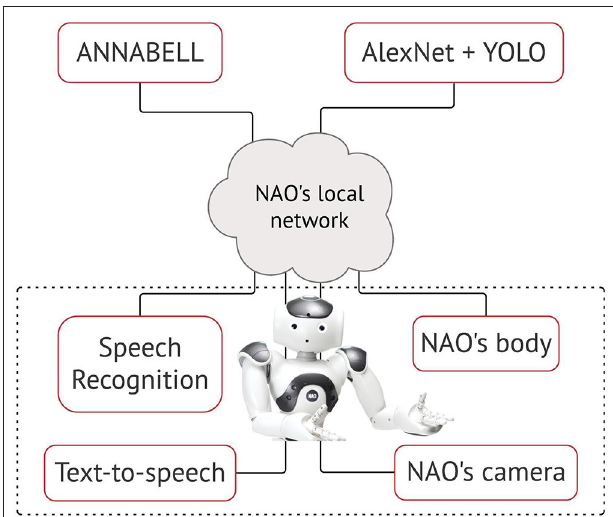
FIGURE 2 | The on-world embodiment of the cognitive model ANNABELL on the NAO robot.